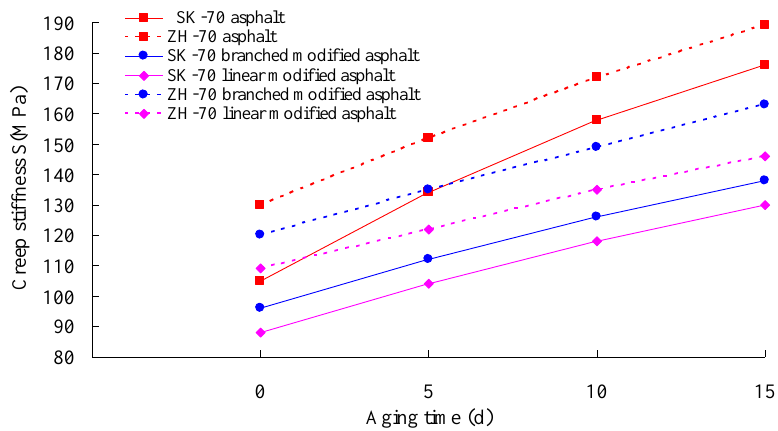
Figure 9. Decrease rate of creep stiffness change rate and aging time.